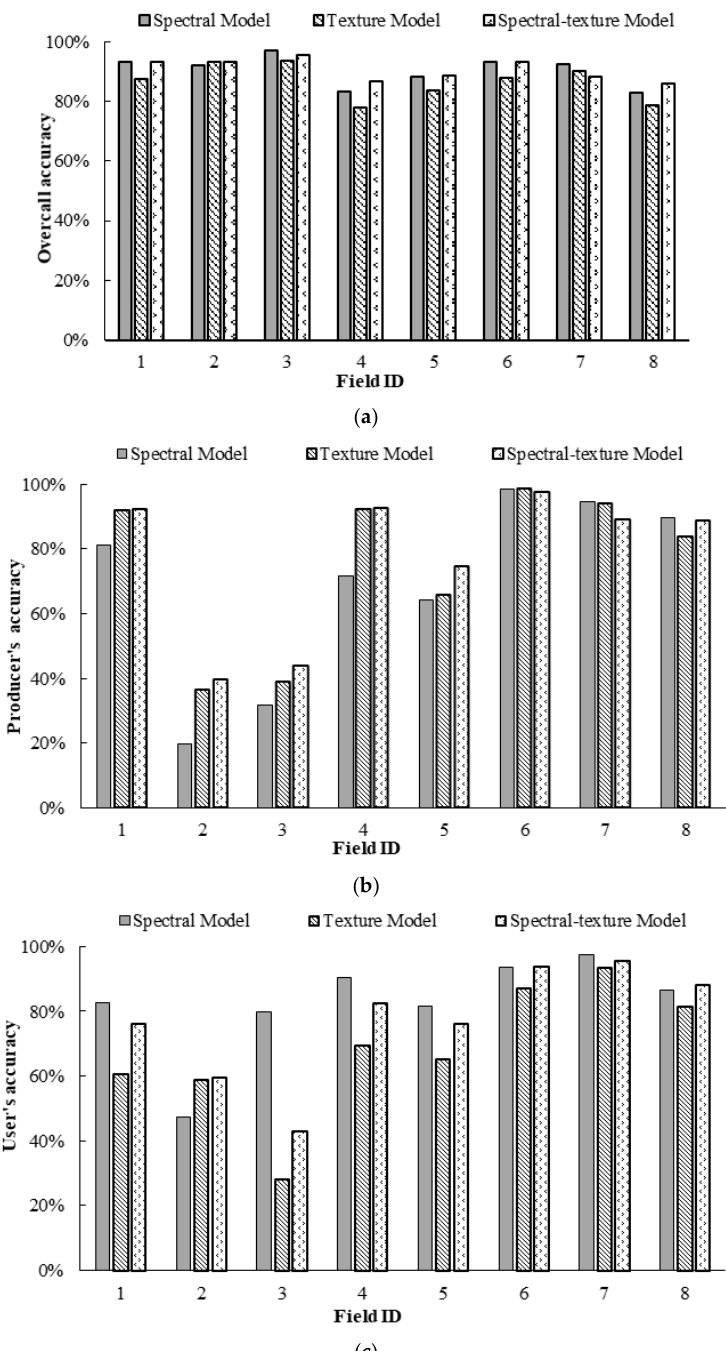
Figure 9. Comparison of classification accuracy of prescription maps generated from Sentinel images by three binary logistic regression (BLR) models for Fields 1–8: ( a ) overall accuracy (OA); ( b ) producer’s accuracy (PA) for the treatment category; ( c ) user’s accuracy (UA) for the treatment category.